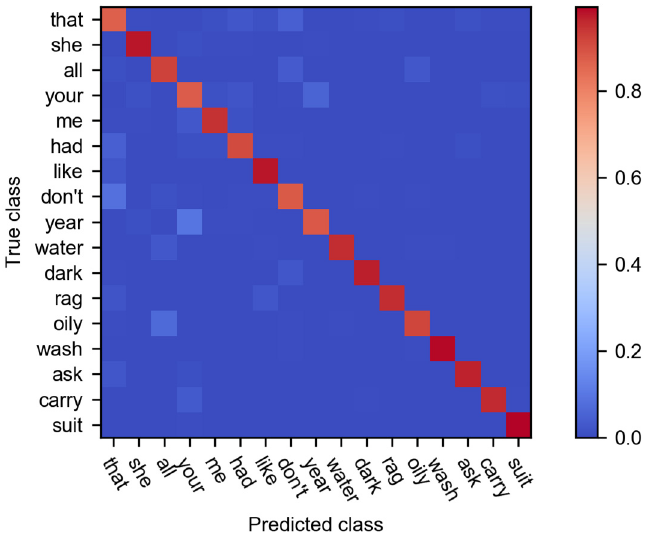
Fig 10. Confusion matrix of the classification result on the test set of the TIMIT dataset. The diagonal values represent the ratio of correct classifications for each word, and the off-diagonal values represent the misclassifications.